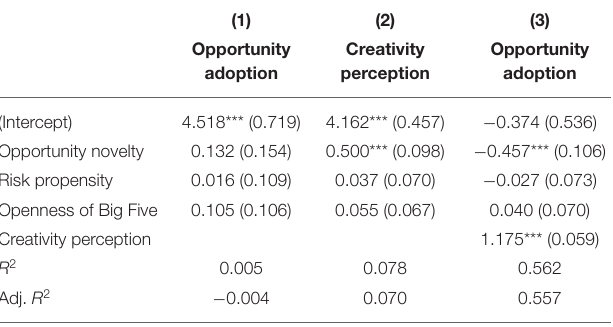
TABLE 4 | Results for the mediating effect of creativity perception on the relation between opportunity novelty and opportunity adoption. TABLE 6 | Results for the mediating effect of risk perception on the relation between opportunity novelty and opportunity adoption.